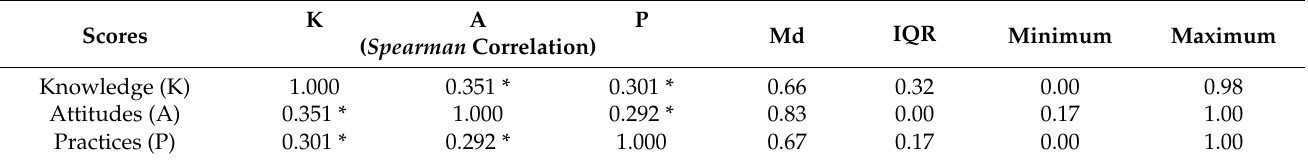
Table 2. Scores of knowledge, attitudes and practices of residents from Feira Grande, Alagoas, Brazil, in